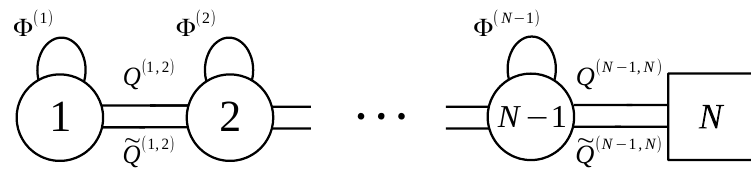
Figure 8 . Quiver diagram for T [SU( N )] in N = 2 notation. Round nodes denote gauge symmetries and square nodes denote global symmetries. Single lines denote chiral (cid:12)elds in representations of the nodes they are connecting. In particular, lines between adjacent nodes denote chiral (cid:12)elds in the bifundamental representations of the two nodes symmetries, while arcs denote chiral (cid:12)elds in the adjoint representation of the corresponding node